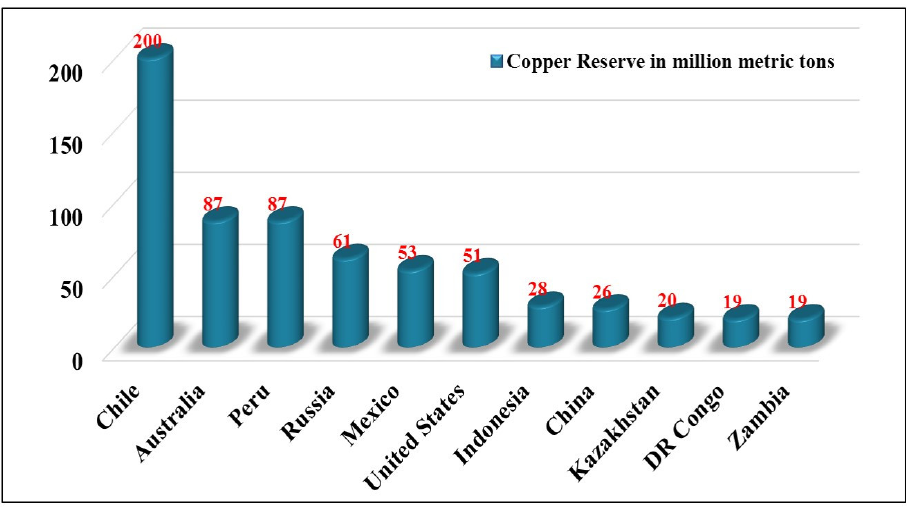
Figure 5. Global Copper Reserves as of 2019 by country [29].